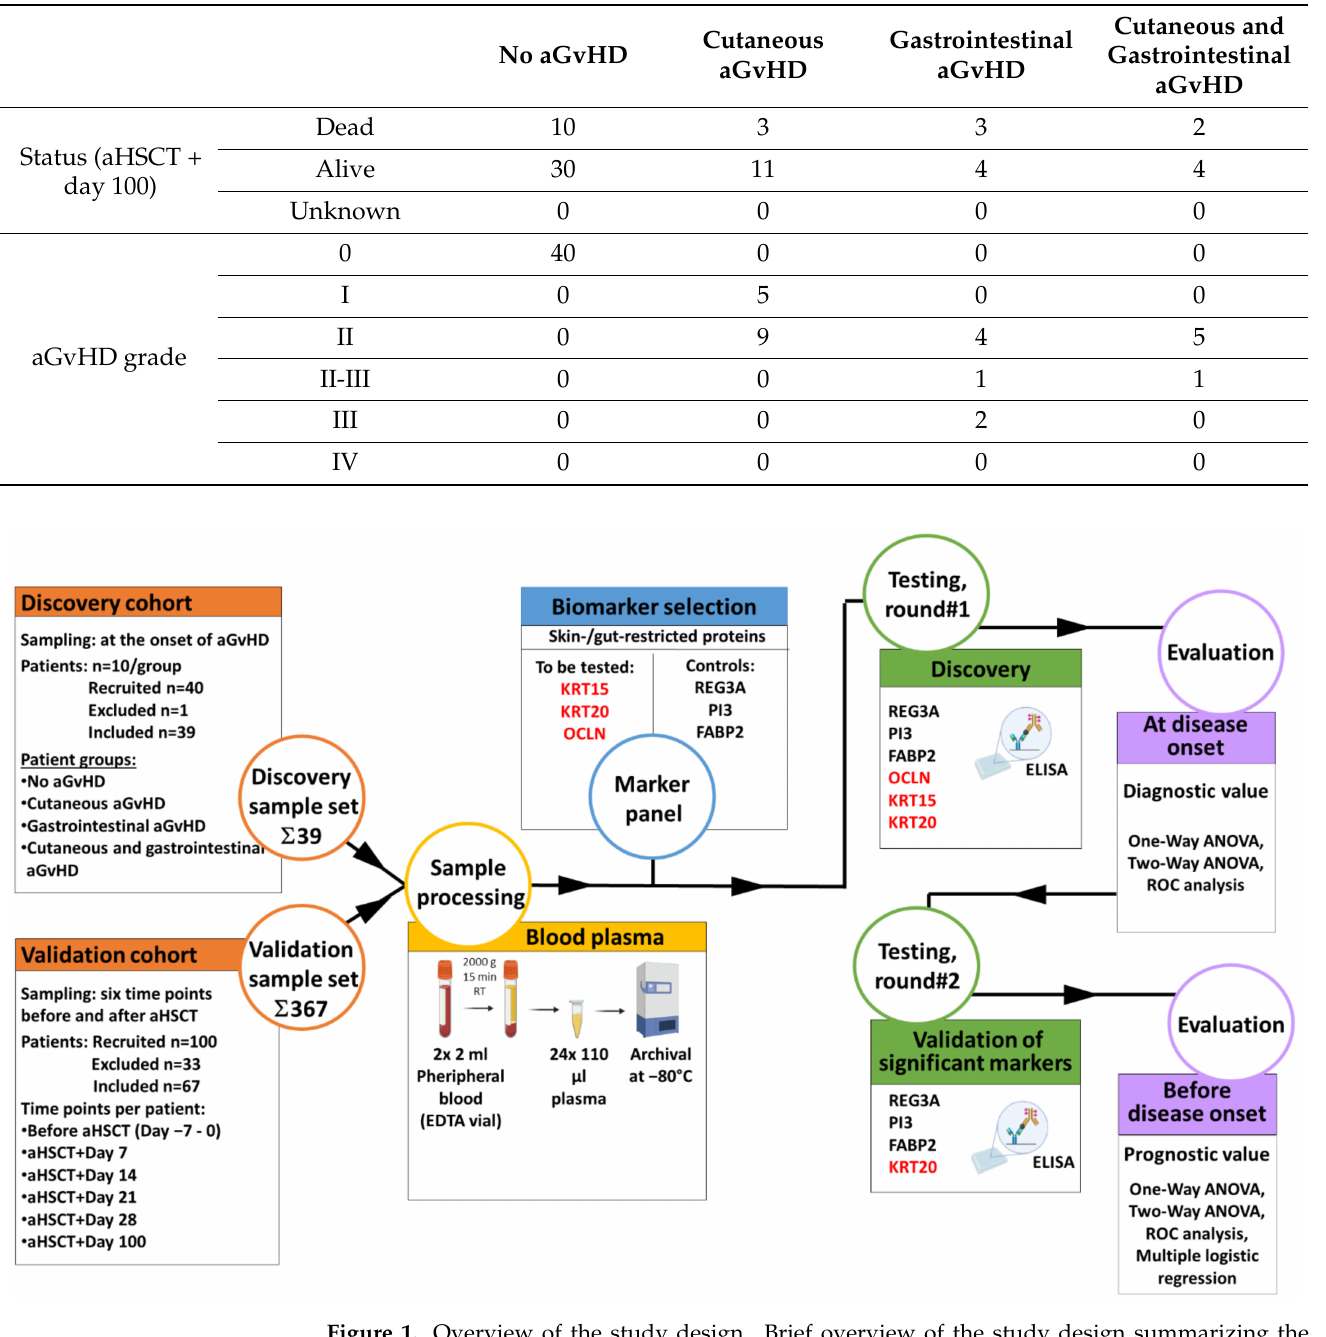
Figure 1. Overview of the study design. Brief overview of the study design summarizing the composition and relationship of the discovery and validation sets, the parameters of sample collection and processing, the markers studied, the reference markers included, and the statistics